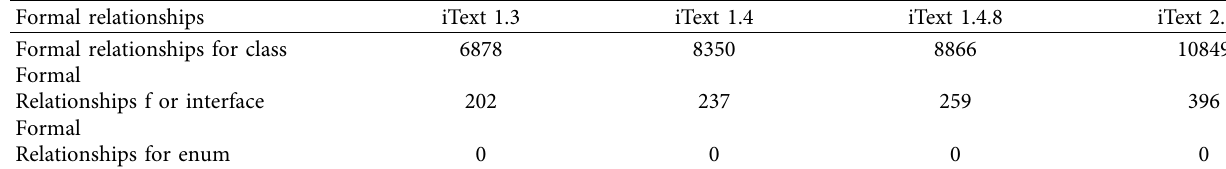
Table 7: Formal relationship in iText.